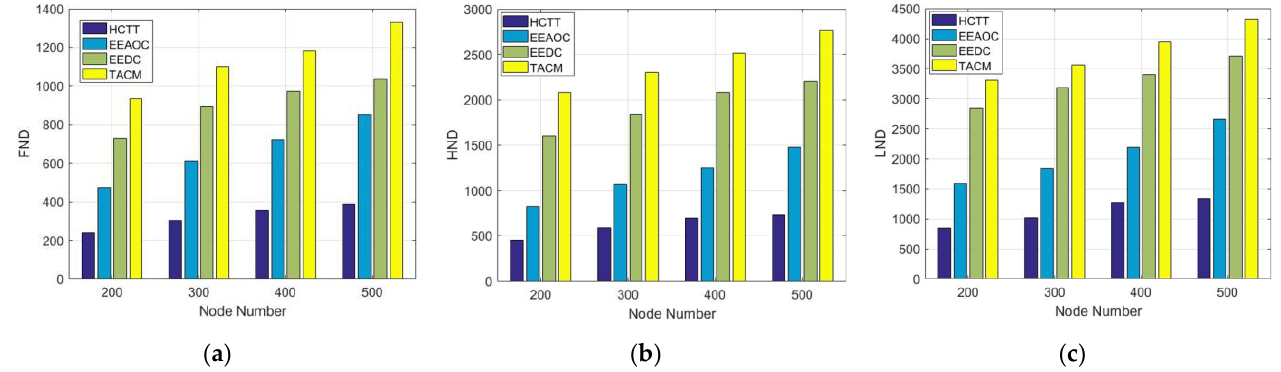
Figure 13. Experimental result for network lifetime ( a ) First node dead; ( b ) Half node dead; ( c ) Last node dead.